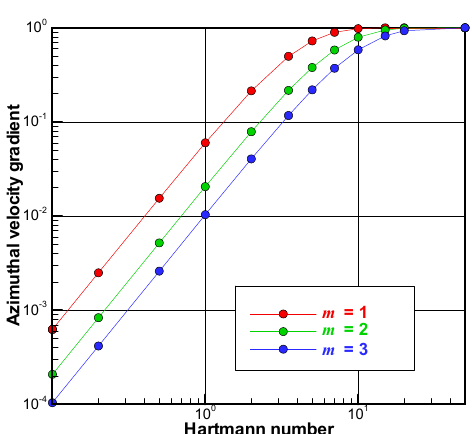
Figure 3. The azimuthal velocity of the basic flow for several numbers of the pole pairs and the Hartmann numbers. ( a ) Ha = 0.1; ( b ) Ha = 7; ( c ) m = 1; ( d ) m = 3.